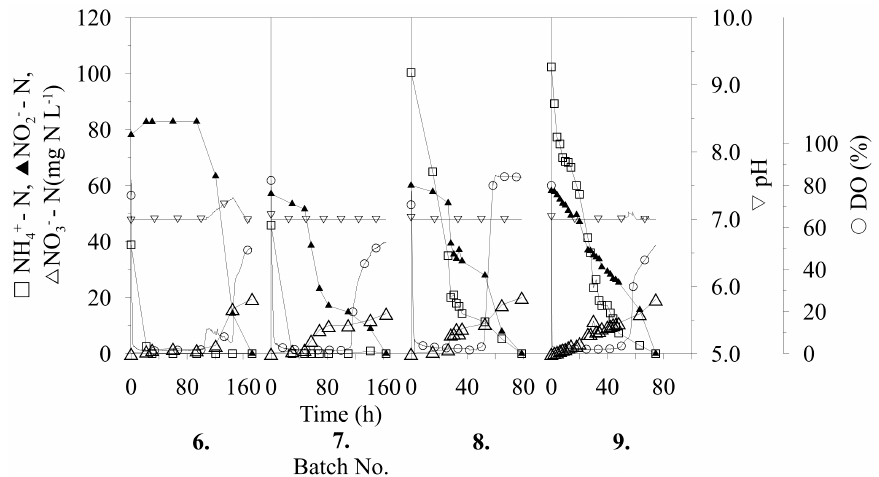
Figure 1. Repeated batch biotransformations with immobilized co-culture of anammox (AMX) bacteria and ammonia oxidizing bacteria AOB.